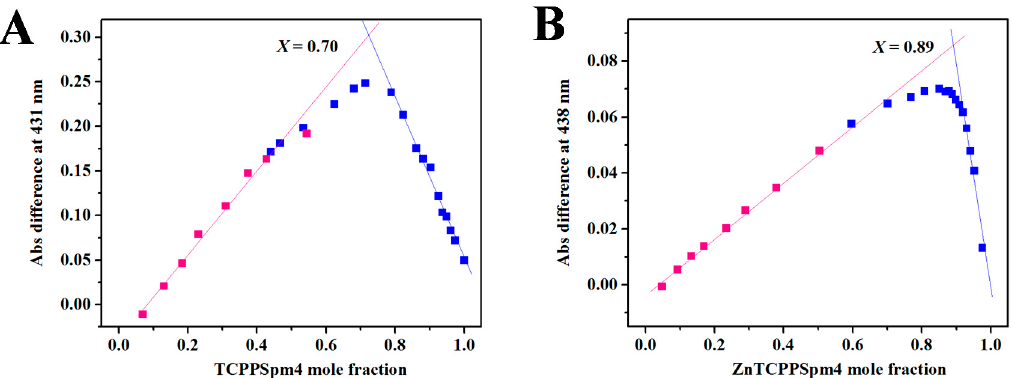
Figure 3. Representative Job plots for ( A ) 3.1 µ M TCPPSpm4 and ( B ) 2.9 µ M ZnTCPPSpm4 in complex with Tel22 at 25 °C. Porphyrins and Tel22 GQ DNA concentrations were maintained equal within 20%. The Job plots were constructed by plotting the difference in the absorbance values at a specified wavelength vs mole fraction of the porphyrin, X . Pink squares represent data collected by titrating porphyrins into DNA; blue squares represent data collected by titrating DNA into porphyrins.